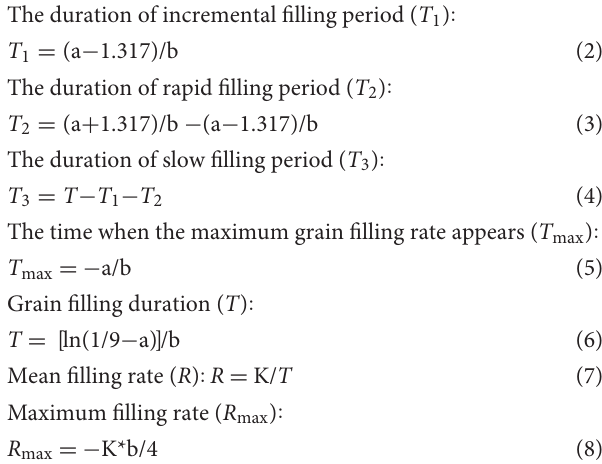
maximum grain weight, and a and b are constants (Darroch